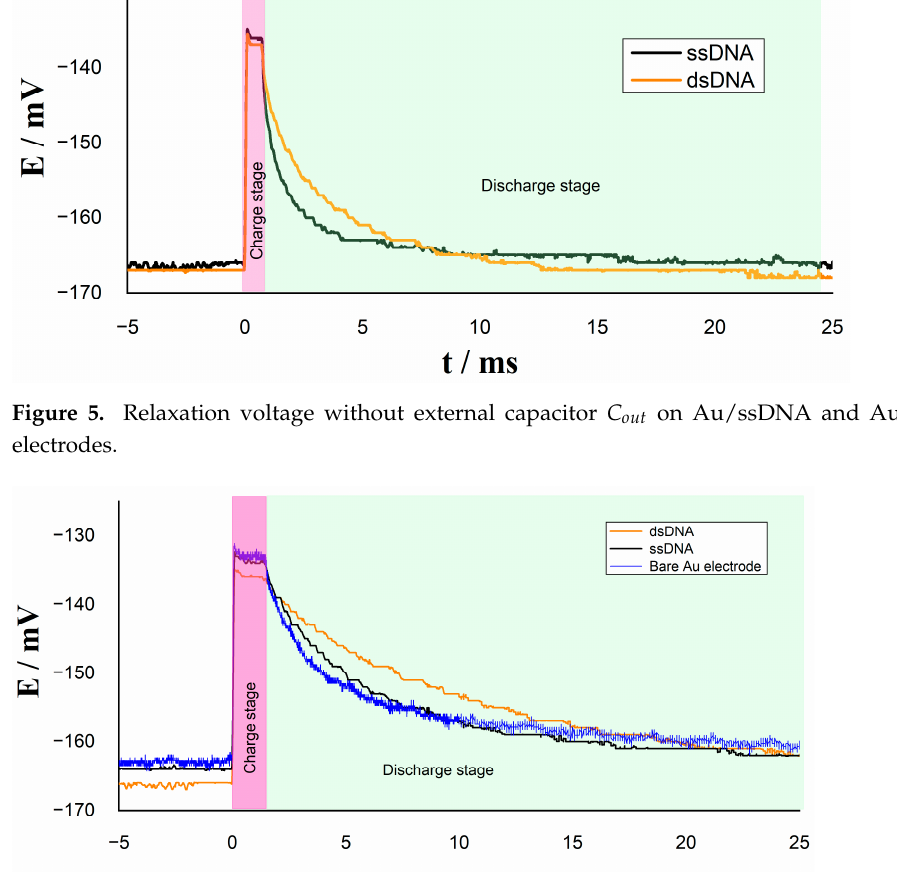
Figure 7. Relaxation current with external capacitor 𝐶 (cid:3042)(cid:3048)(cid:3047) on different electrodes.